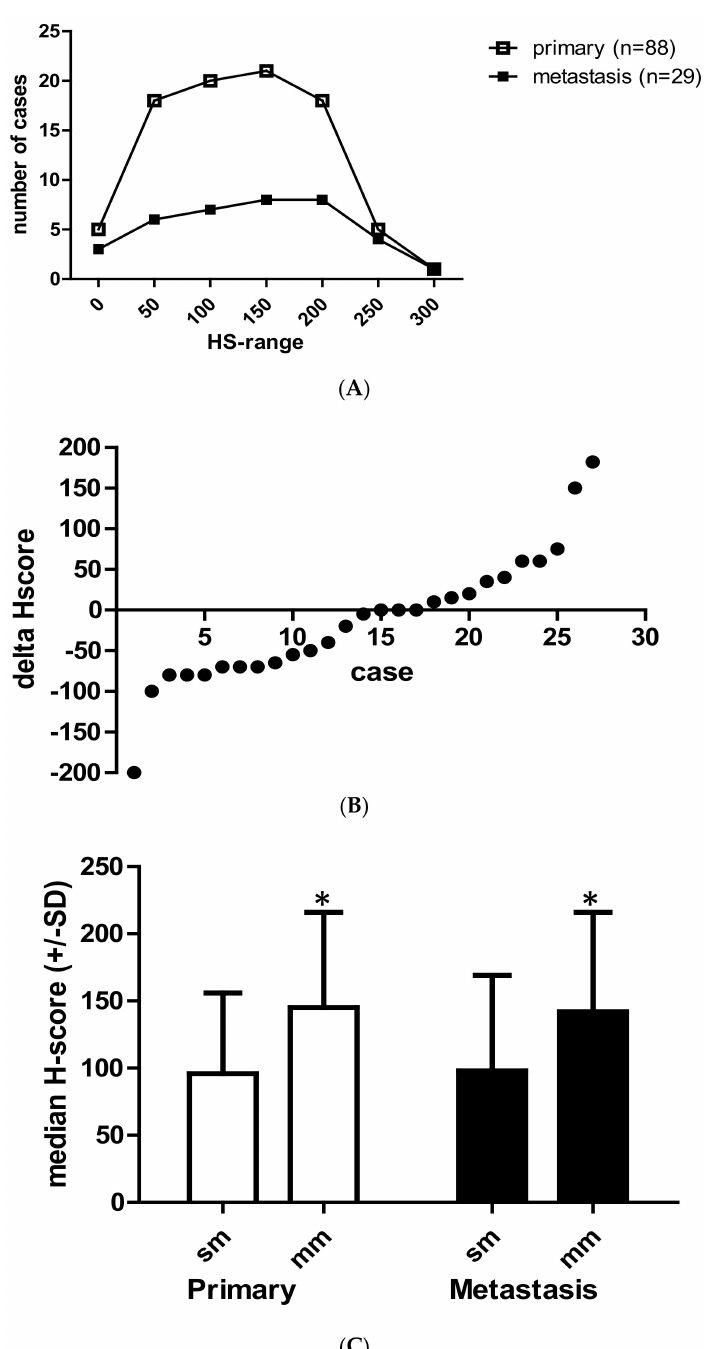
Figure 2. Comparison of the EGFR protein expression in primary and metastatic colorectal cancer tissues. ( A ) Distribution of EGFR expression levels in primary versus metastatic tumor tissues as represented with various H-score ranges. ( B ) Variations of EGFR-HS (H-score) in colorectal cancer metastases as compared to the corresponding primary tumor ( N = 27). Data are expressed as H-score di ff erences of metastatic minus primary tumor at individual case level. (0 = no change, negative value = decrease, + value = increase). ( C ) Comparison of EGFR H-score of the primary tumors with di ff erent metastatic potentials (single metastasis, sm, N = 22) versus multiple-metastasis, (mm N = 66), * p = 0.007. Comparison of metastatic tumors with single metastastasis (sm) versus multiple metastases (mm), ** p = 0.04. Data are expressed as median +/ − SD, Mann–Whitney